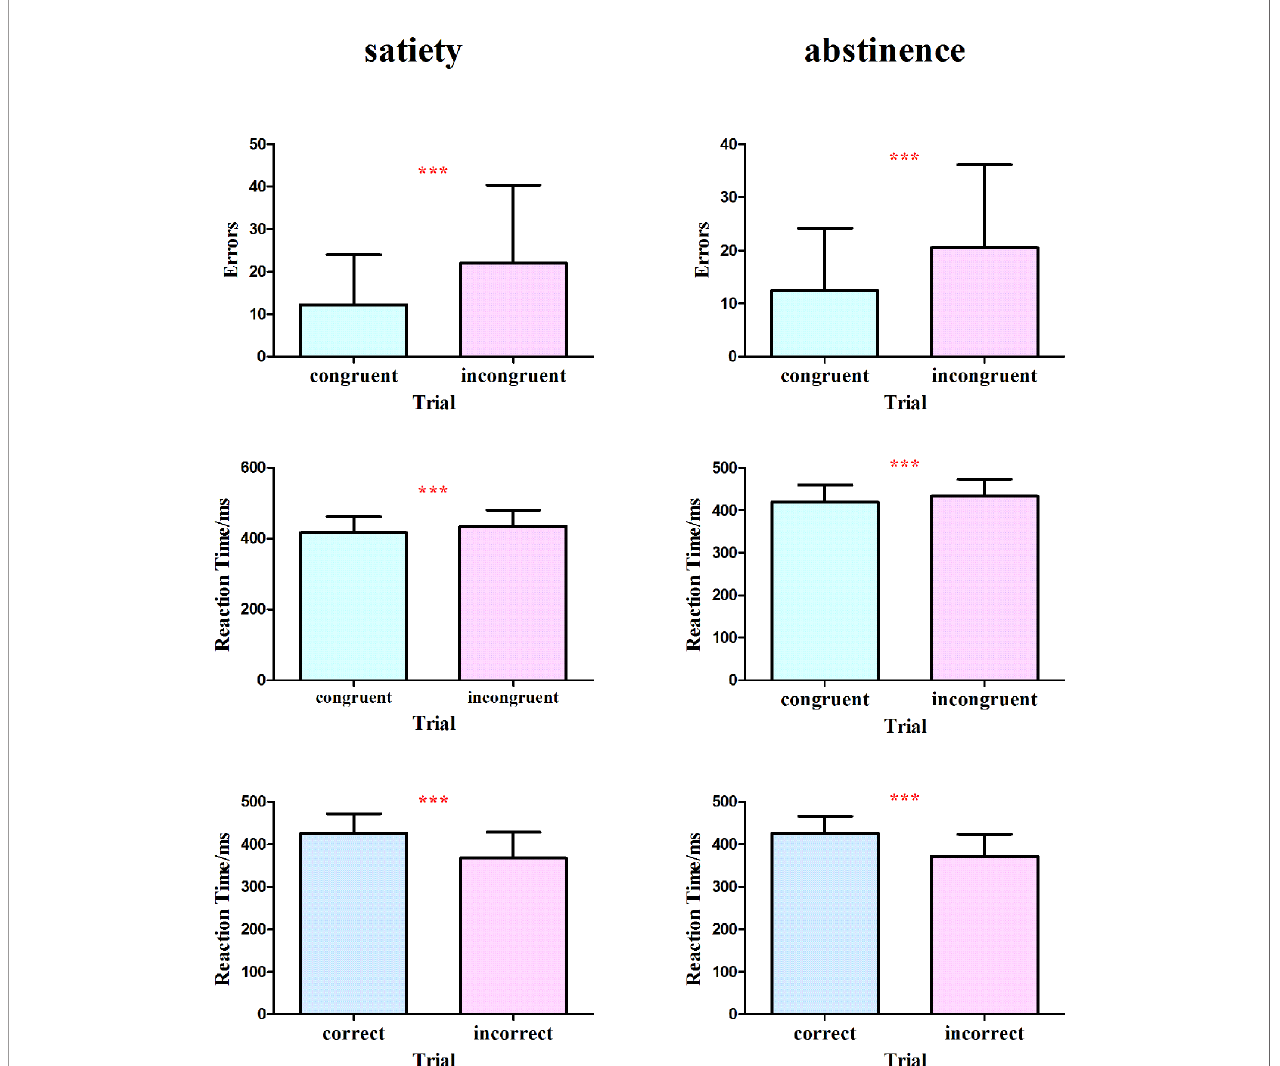
FIGURE 3 | No signi fi cant difference was found in the total number of errors between the smoking satiety condition and the 12-h abstinence smoking condition (t = − .182, p = .858). More errors were found on the incongruent trials than on the congruent (t = − 7.560, p < .000) and responses were markedly faster on congruent trials (t = − 9.842, p < .000) in both two conditions. Moreover, it took more time to respond on the correct trials as compared to incorrect trials (t = 10.993, p < .000). ***p < 0.001. *** Represents that there are signi fi cant differences in the number of errors and reaction time between different trial